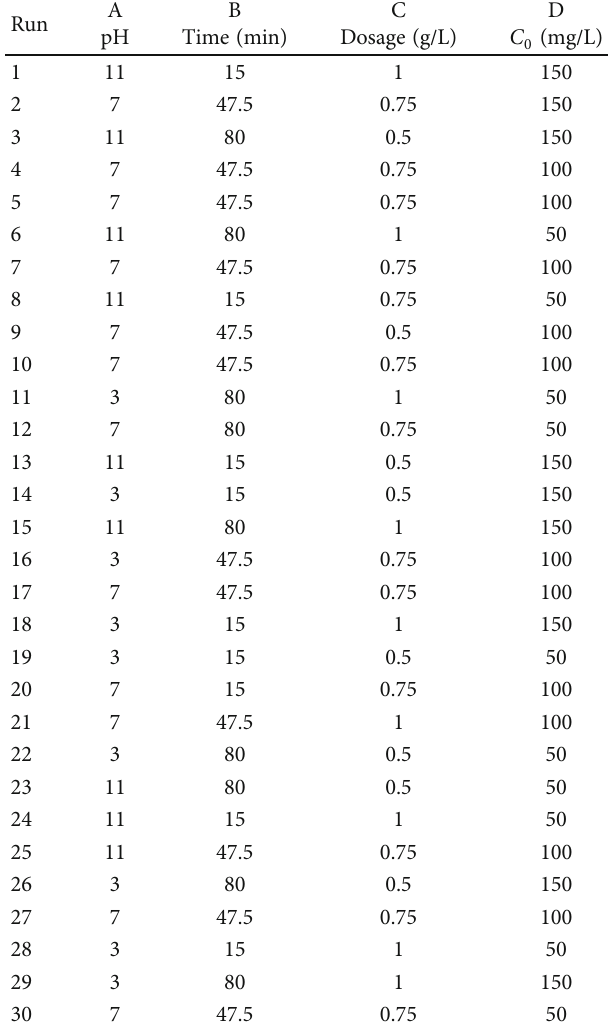
Table 1: Predicted and experimental values for CEX by Fe O @SIO 3 4 2